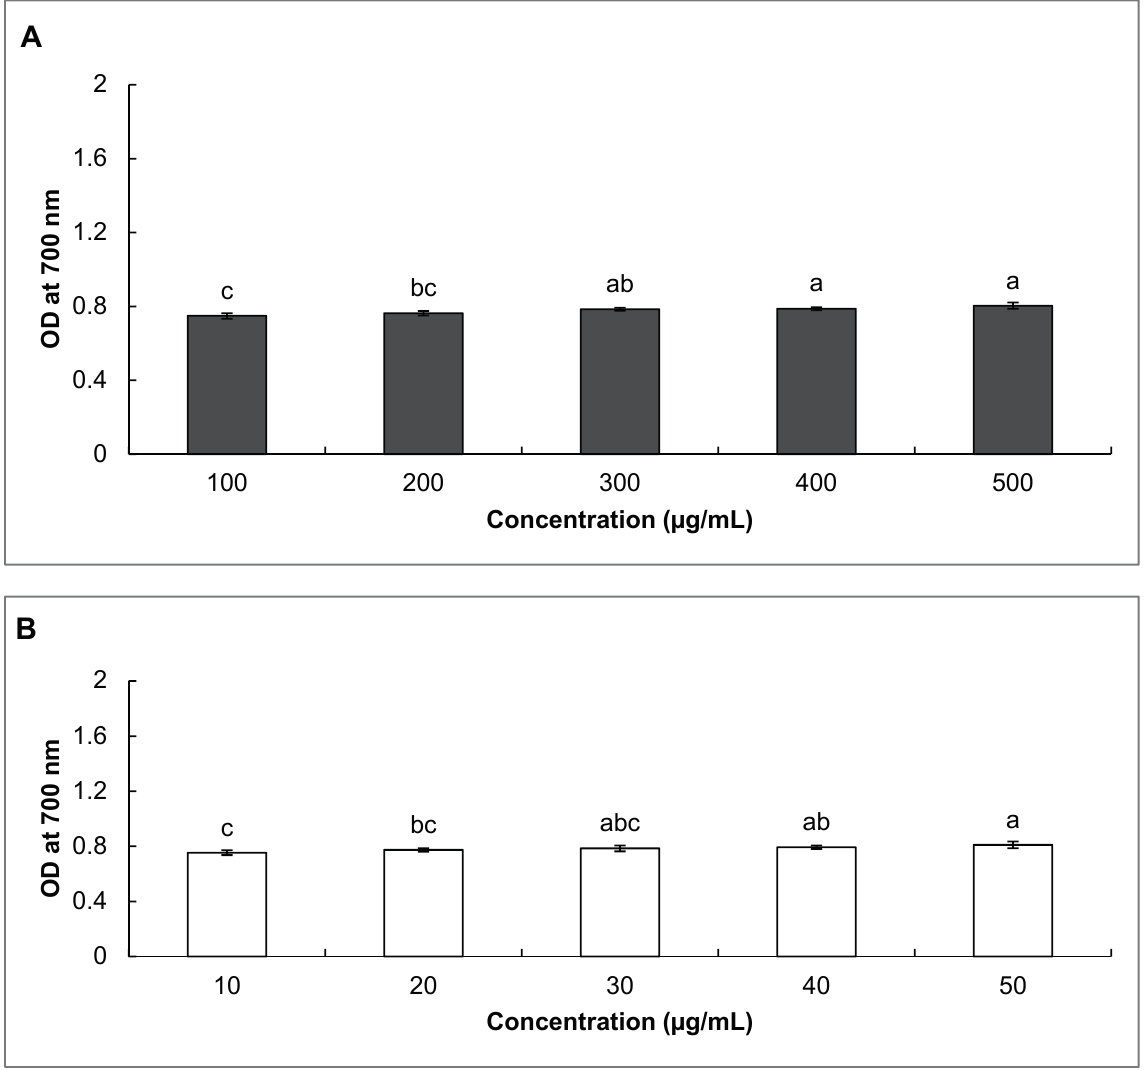
Figure 4. Reducing power of ( A ) Japanese red pine sawdust bio-oil (SBO) and ( B ) gallic acid as the reference. Columns with different superscript letters indicate a significant difference at p <